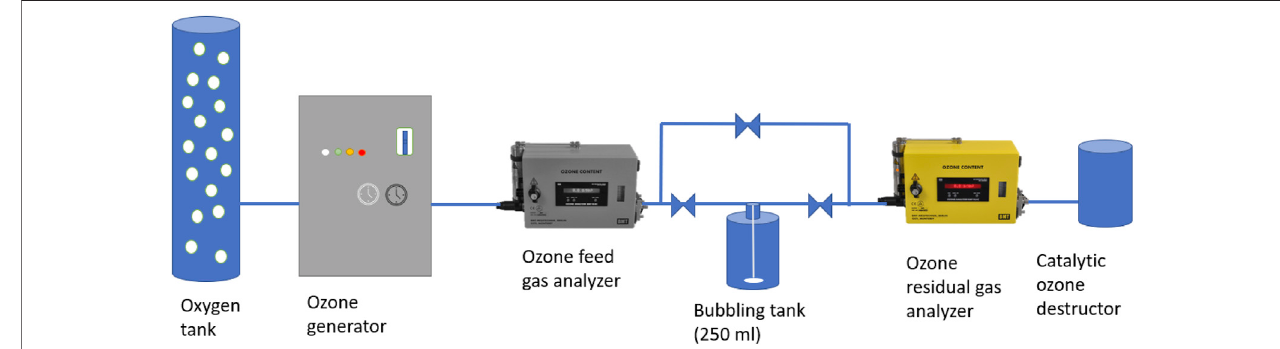
FIGURE 1 | Schematic diagram of the experimental ozone set-up in the